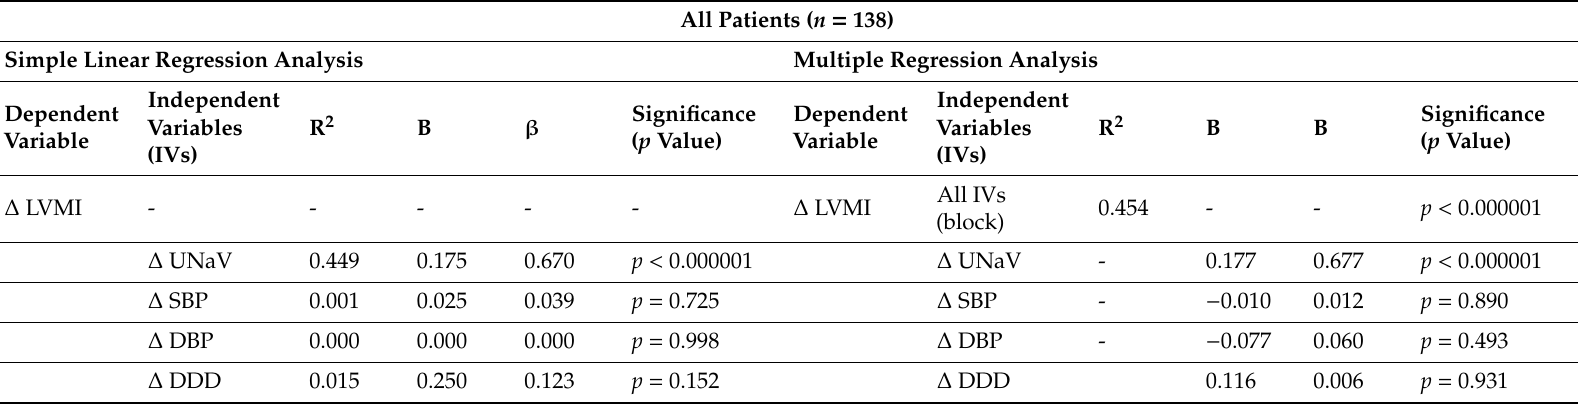
Table 4. Simple and multiple regression analysis evaluating the impact of sodium excretion, BP and drug consumption on left ventricular mass changes. All Patients ( n =